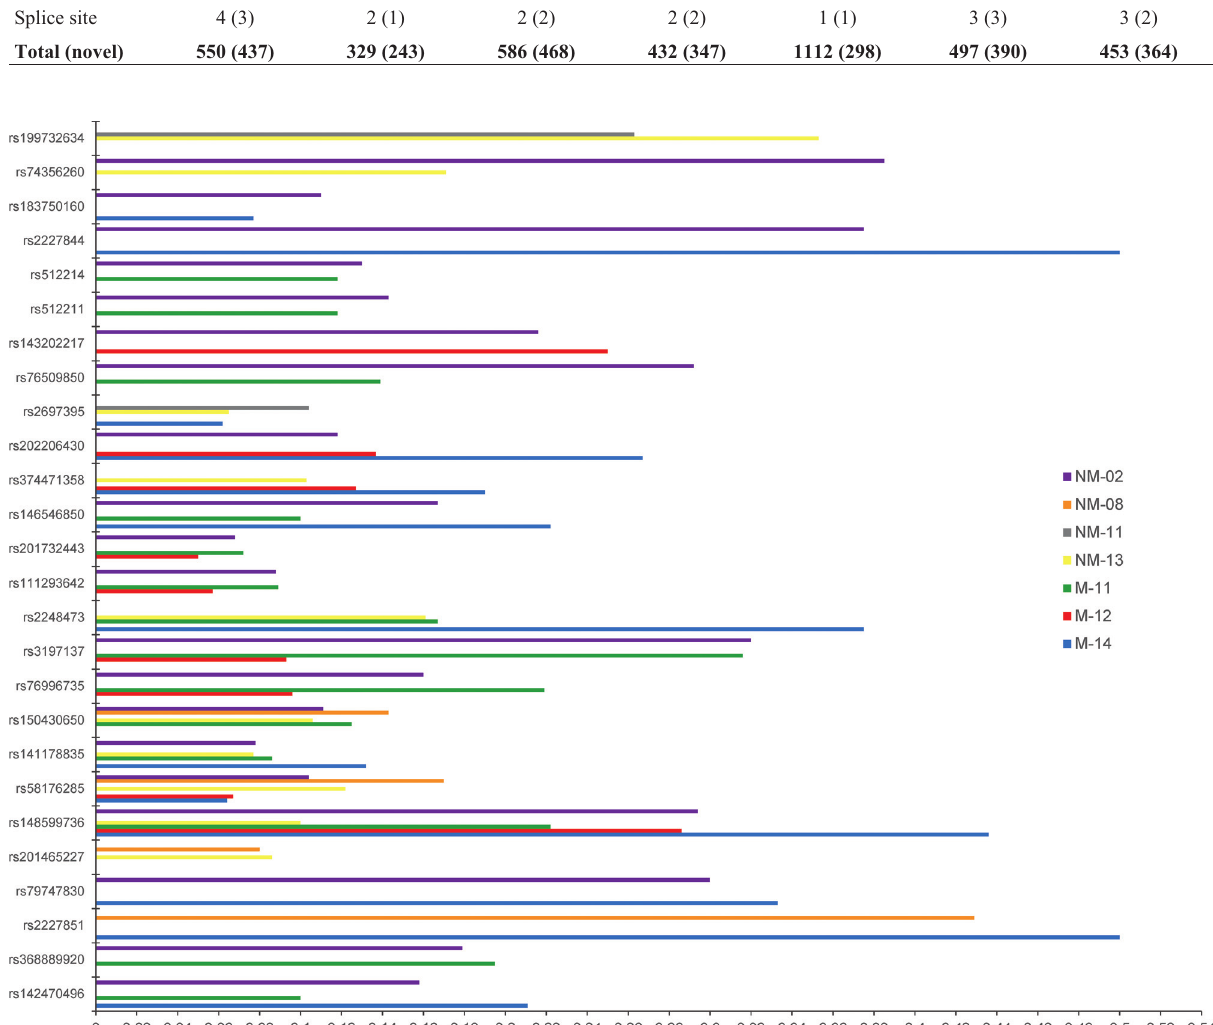
Figure3 -Somaticcodingsinglenucleotidevariants(SNV)foundin (cid:4) 2HNSCCpatientsanddbSNPdatabase.Thevariantallelefrequency(VAF)onthe x-axis indicates the proportion of reads with the variant allele within individual